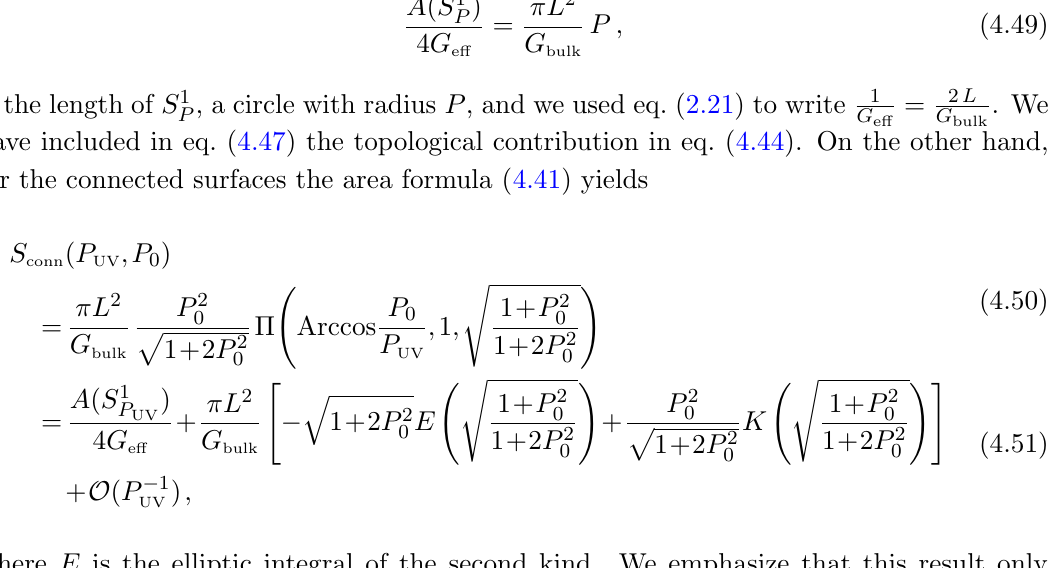
(cid:24) c T , the connected solution becomes GB